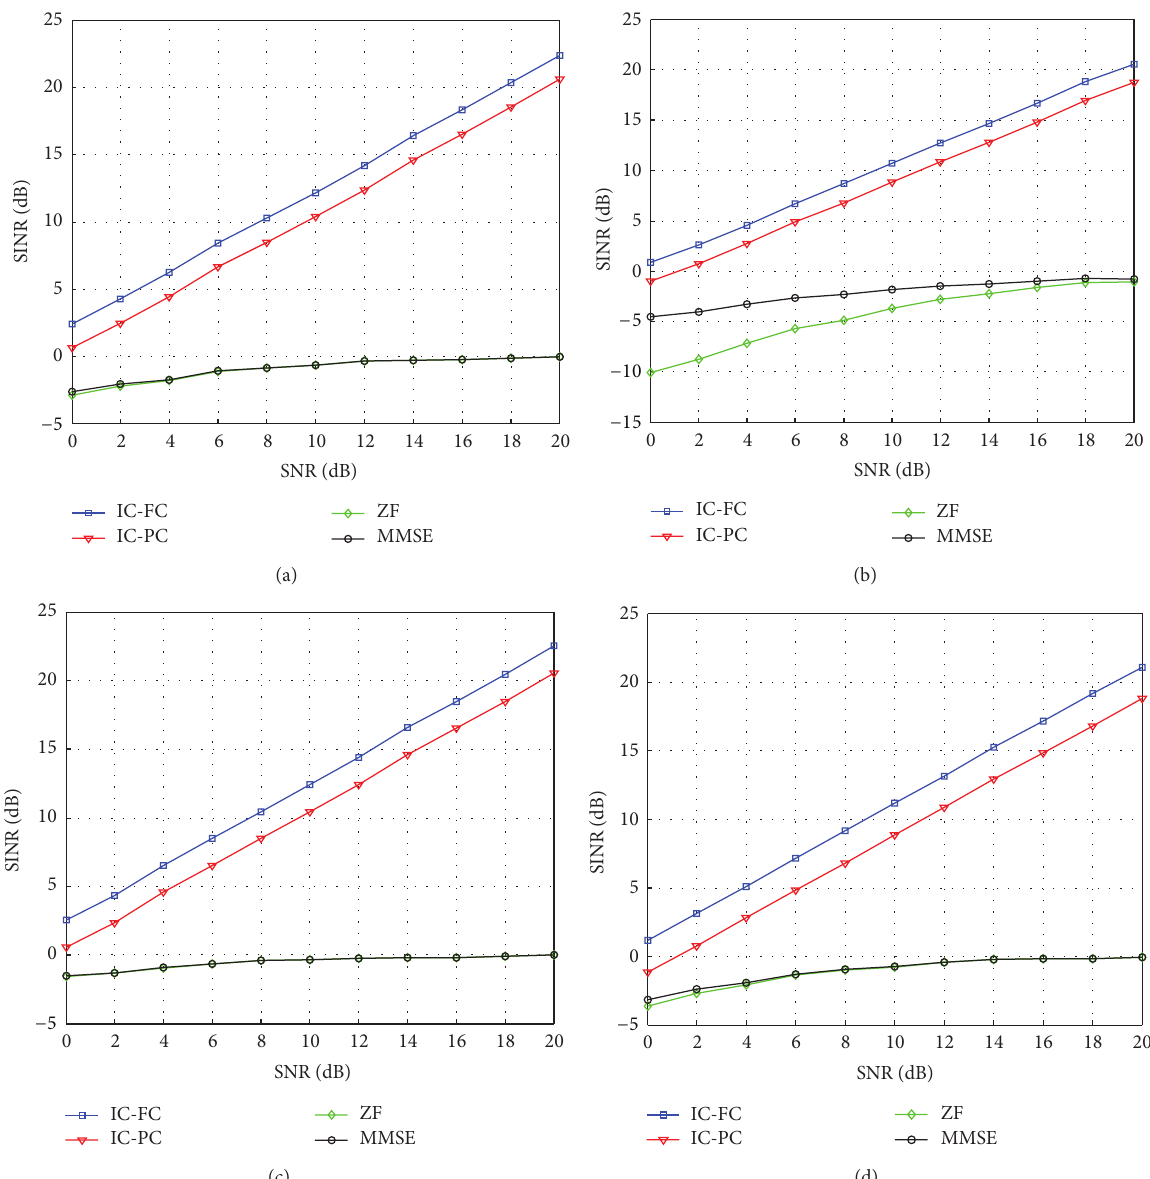
Figure 2: Link level results of receive SINR for single picocell scenario, for four cases: (a) 𝑛 𝑀 = 4 , 𝑟 = 1 ; (b) 𝑛 𝑀 = 4 , 𝑟 = 2 ; (c) 𝑛 𝑀 = 8 , 𝑟 = 1 ; (d) 𝑛 𝑀 = 8 , 𝑟 = 2